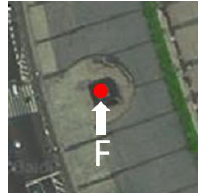
Figure 5. The actual object correspond to F point